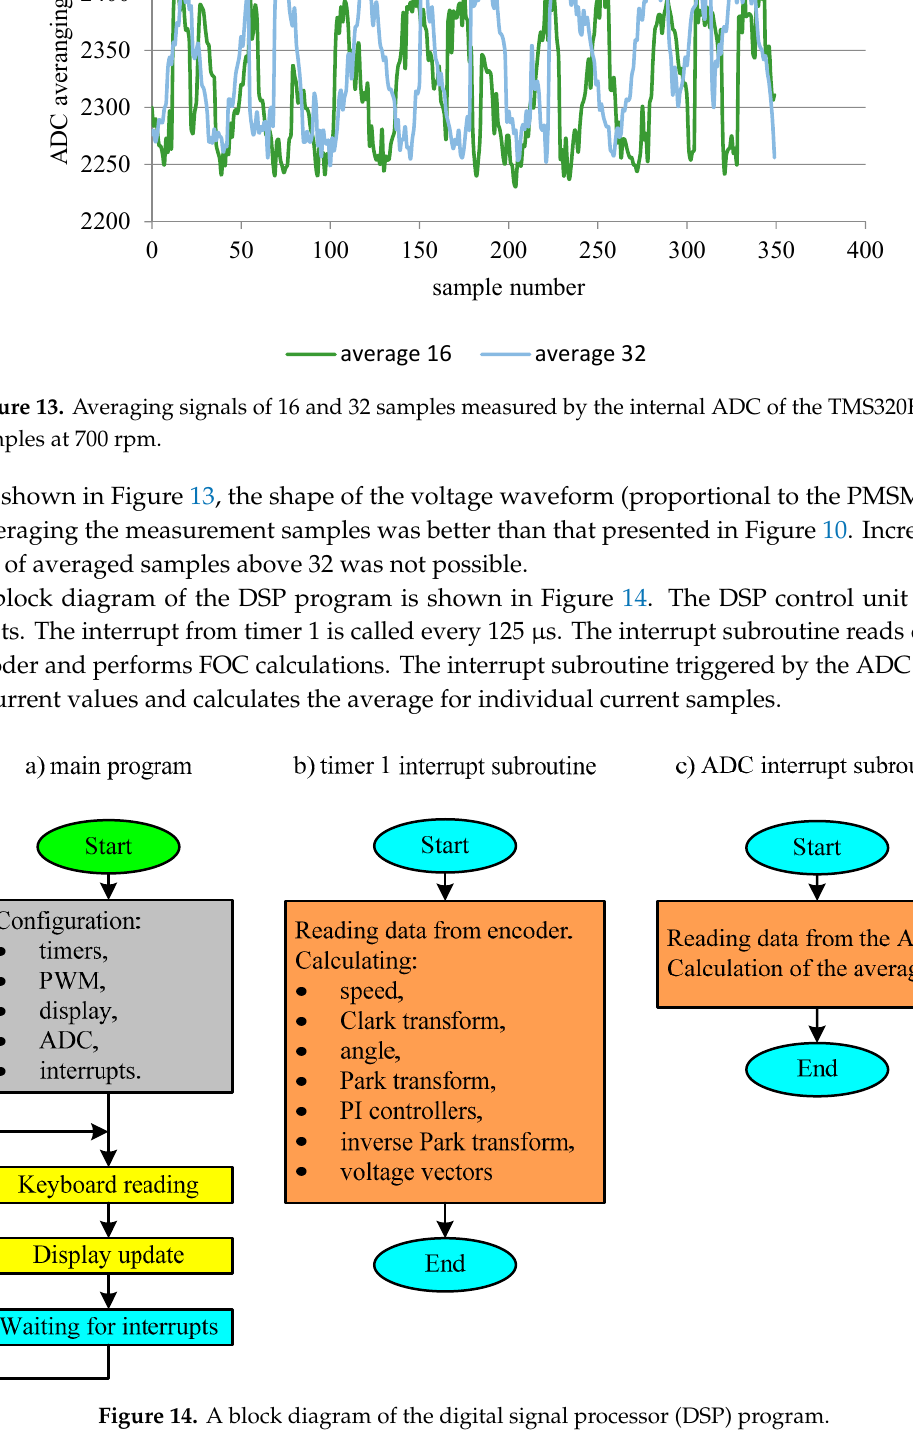
Figure 14. A block diagram of the digital signal processor (DSP) program.